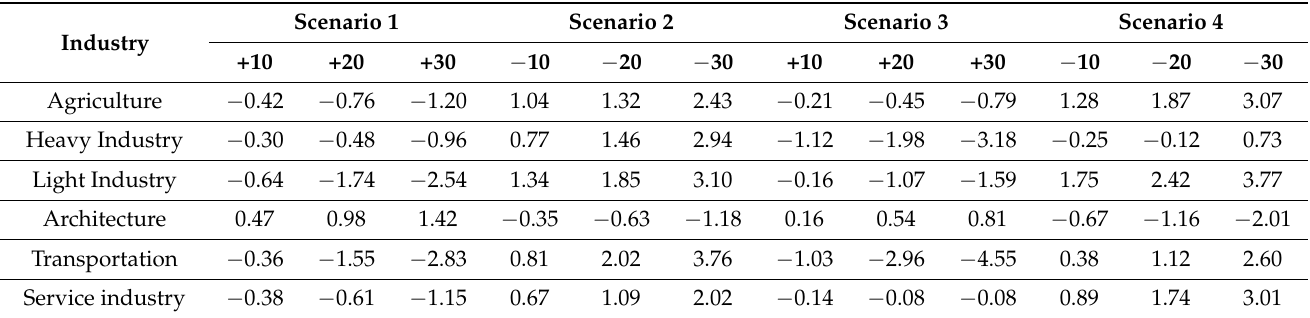
Table 3. Impact of scenario mix on industry output Unit: